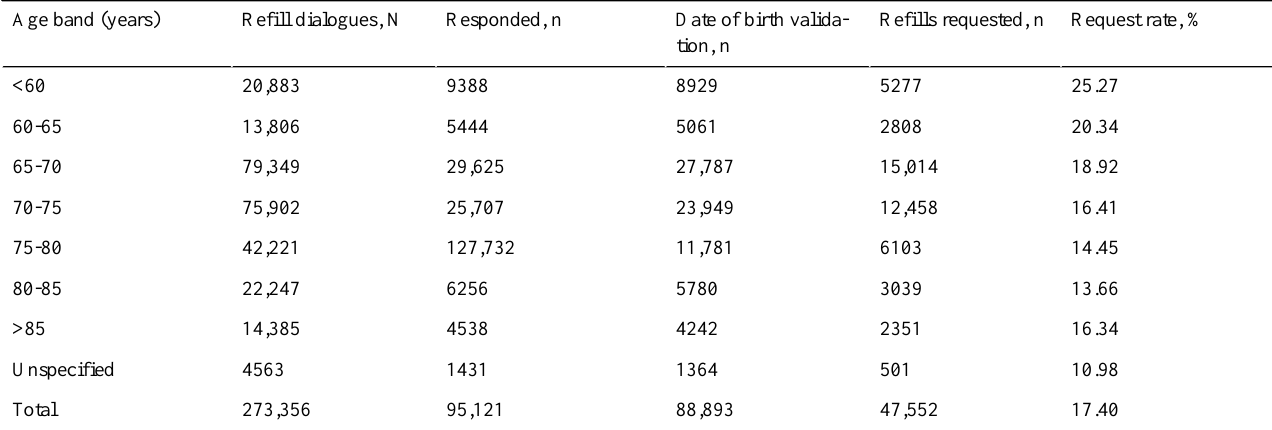
Table 4. Response and refill request rates by age.